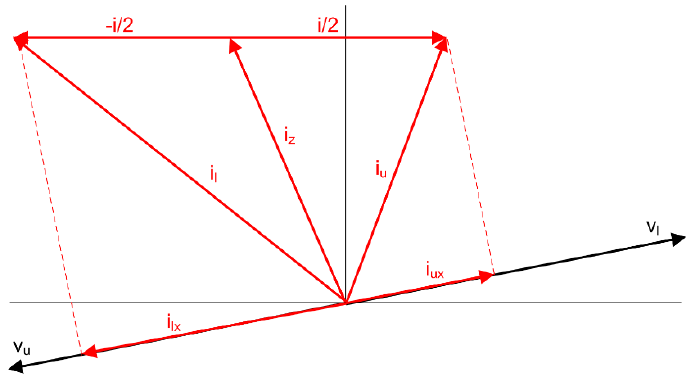
Figure 12. Vector diagram of the variables involved in the transmission of power from the arms when the generation has a medium imbalance between arms. All of them are 50 Hz variables (harmonic 1).